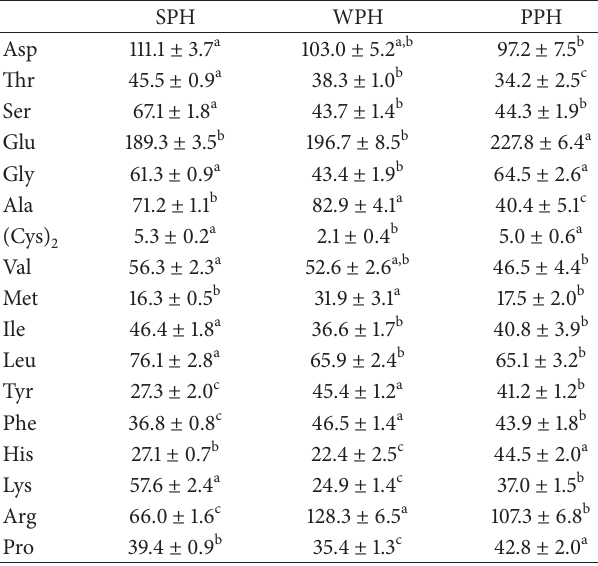
Table 1: Amino acid composition (g/kg) in SPH, WPH, and PPH ∗